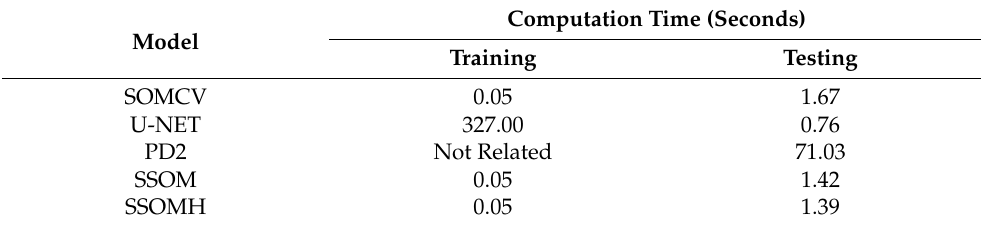
Table 2. Average Computation Time for All